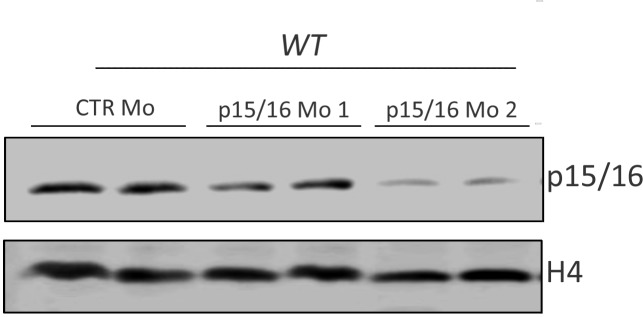
Anti-p16 antibody validation in zebrafish through antisense morpholino knock-down of cdkn2a/b (p15/16).Representative Western blot of p15/16 using 4dpf larvae injected (at 1 cell-stage) with control, 2.4 ng (p15/16 Mo1) or 3.6 ng (p15/16 Mo2) of p15/16 antisense morpholinos. Dose-dependent decrease of p15/16 protein levels with p15/16 morpholinos confirm the specificity of anti-p16 (F-12) (1:50, Santa Cruz Biotechnology, sc-1661) for zebrafish p15/16 protein.